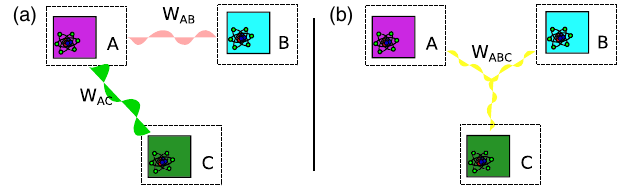
FIG. 6. Two wiring schemes that are equivalent in the LOCC paradigm, but inequivalent according to LOP. For LOCC, i.e., for incoherent states of the wiring, every operation can be performed by acting over the extremes of each wire, without a direct interaction among wires. On the other hand, if wires are quantum, direct interaction among wires enlarges the set of possible inequivalent operations. As a result, the initial coherence neces- sary to prepare a multipartite entangled state depends on the wiring